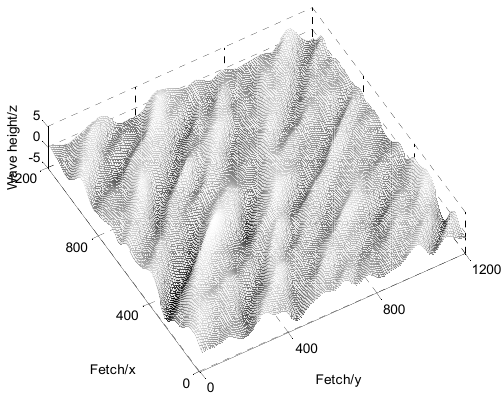
Figure 4. Simulation of 2-D sea surface by fractal method with wind speed 11 km/h, fetch 12 km, wind direction 320° and fractal dimension 1.5.